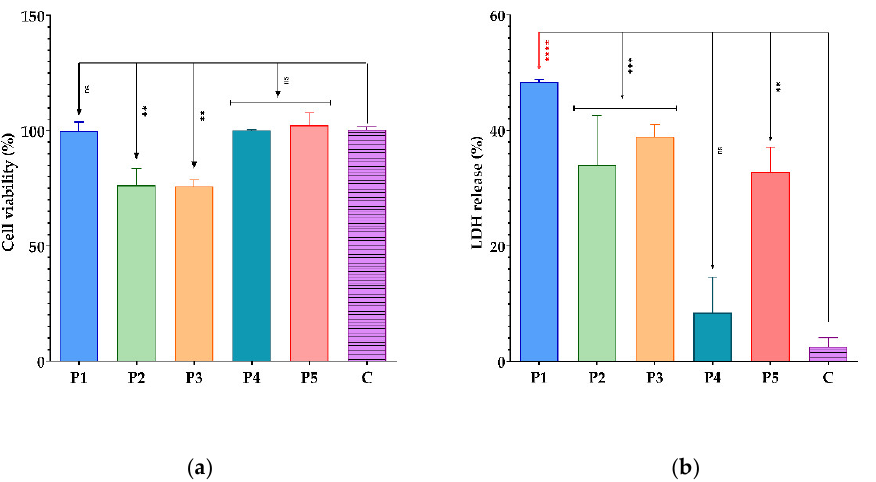
Figure 9. ( a ) Graphic representation of the absorbance values to evaluate the influence of BPEs on cell viability, the proliferation of tumoural cells (MTT assay). ( b ) Graphic representation of the absorbance values to evaluate the cytotoxic effect of BPEs on tumoural cells (LDH assay); (P1–P5) BPE samples, C-cell culture control. The differences between cell viability and proliferation for the MTT assay were statistically analysed using one-way ANOVA followed by Dunnett’s multiple comparisons tests. (ns- p > 0.05; ** p < 0.007); The LDH data were statistically analysed in the same way. (ns- p > 0.05; ** p = 0.0013; *** p ≤ 0.0009; **** p < 0.0001).